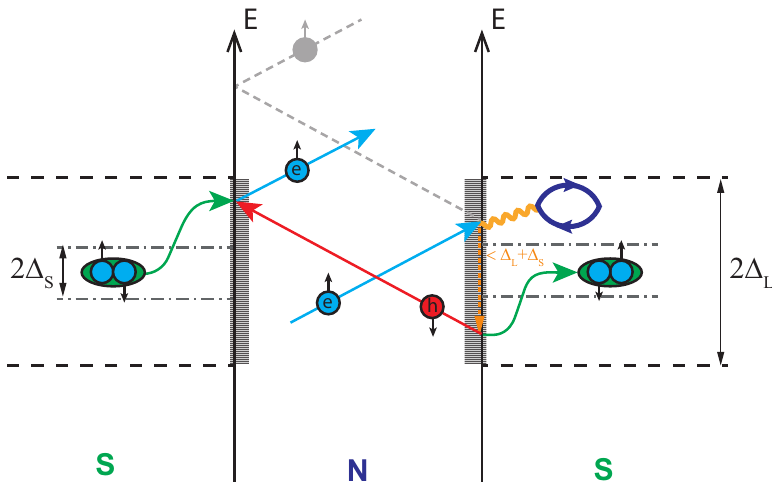
Figure 3. Scheme of the multiple Andreev scattering where electron from the normal metal (N) within the proximity range near the superconductor (S) can scatter on the spin exciton (shown as the electron- hole bubble), lose energy ε 0 < ∆ L + ∆ S , and then form a Cooper pair inside the superconductor. Andreev reflected hole travels to the other side of the normal metal and, by annihilating with one electron from a Cooper pair of the left-hand side superconductor, results in the reflection of the electron.